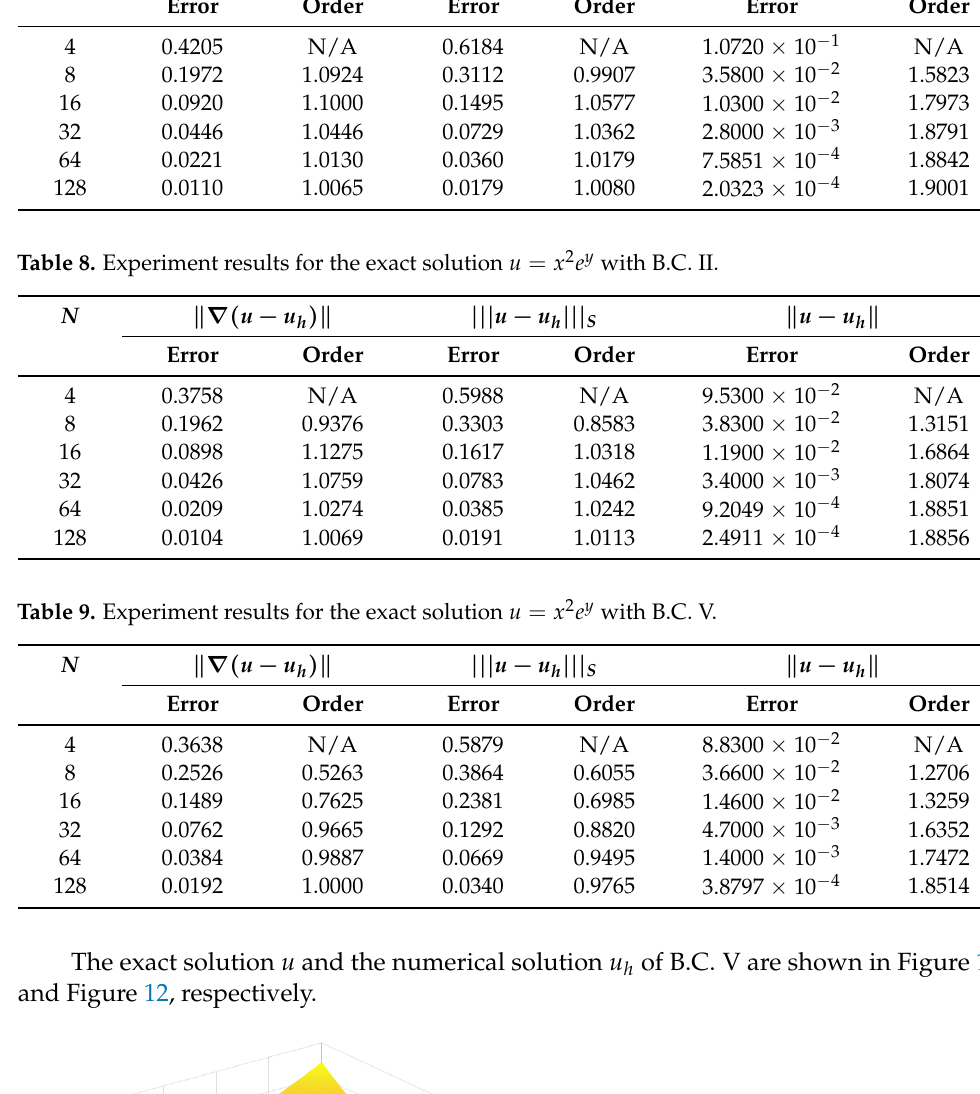
Table 7. Experiment results for the exact solution u = x 2 e y with B.C. I. Experiment results for the exact solution u = x 2 + e y with B.C. II. N